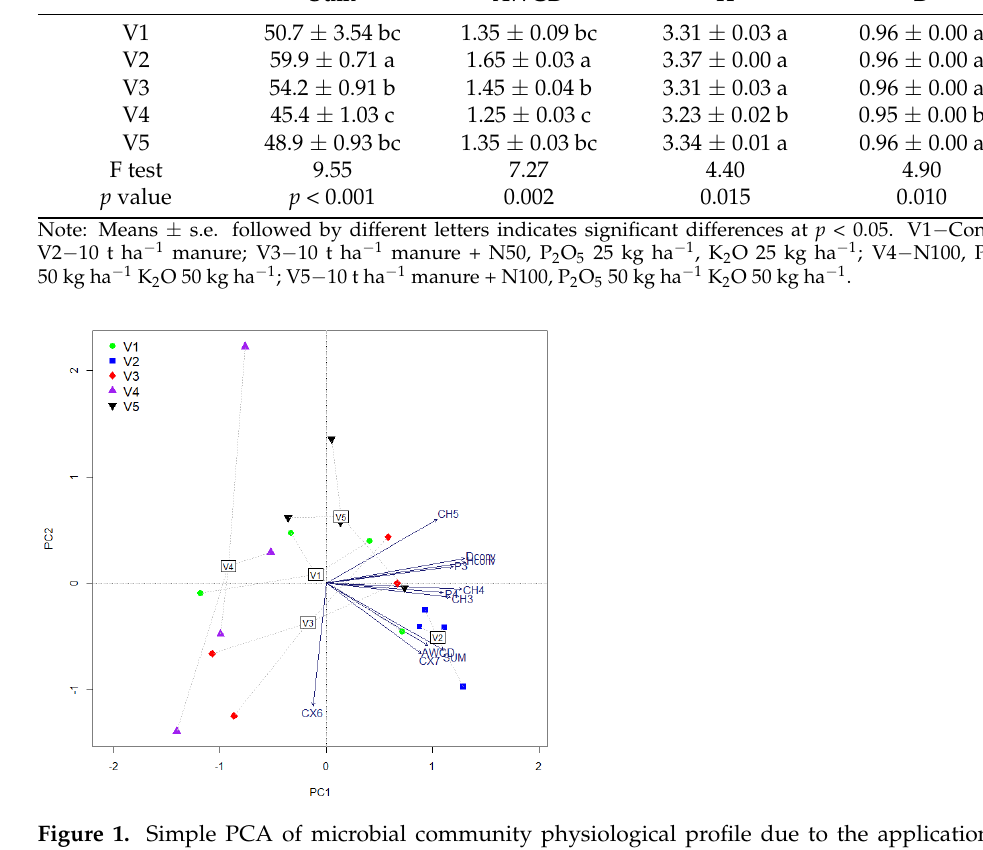
Figure 1. Simple PCA of microbial community physiological profile due to the application of treatments. (Variance explained by axes: Axis 1 − 28.68%, Axis 2 − Table 1. Functional microbiome dimension and indicators due to applied treatments.